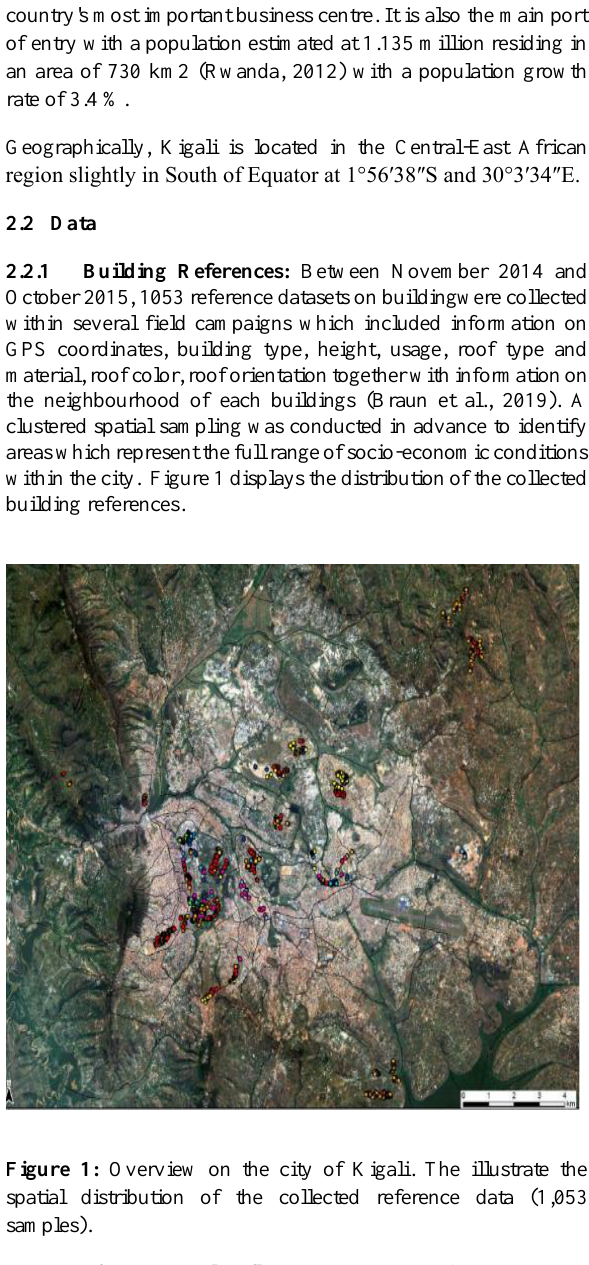
Figure 2: 10 Corrugated Metal, partly slight